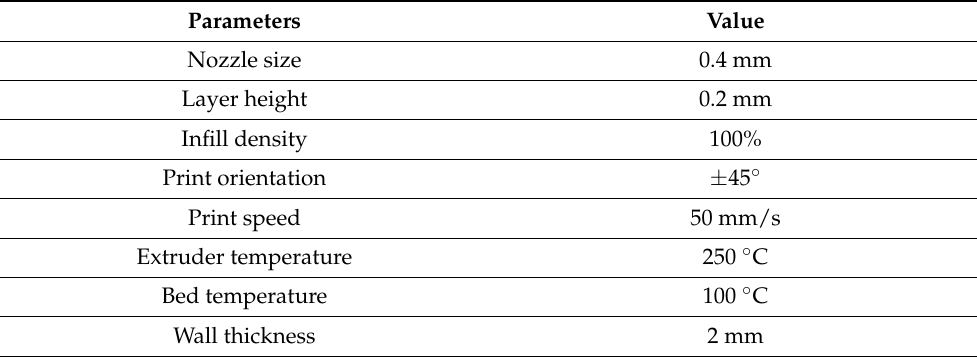
Table 1. Printing parameters of the ABS skin.